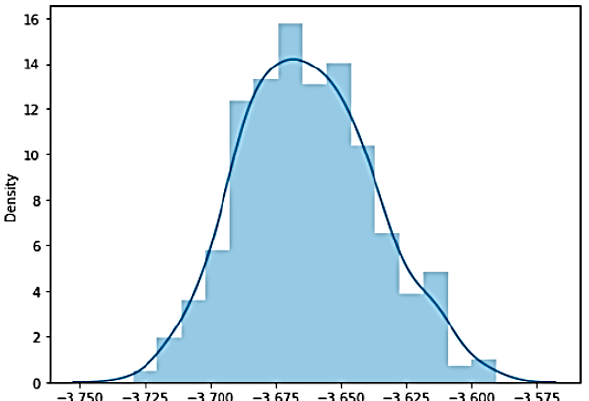
Figure 14. Example of a normal distribution for generic input data.